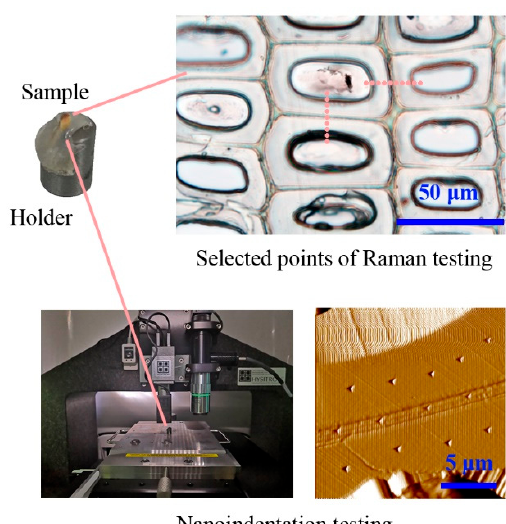
Figure 1. Schematic illustration of nanoindentation and Raman testing.